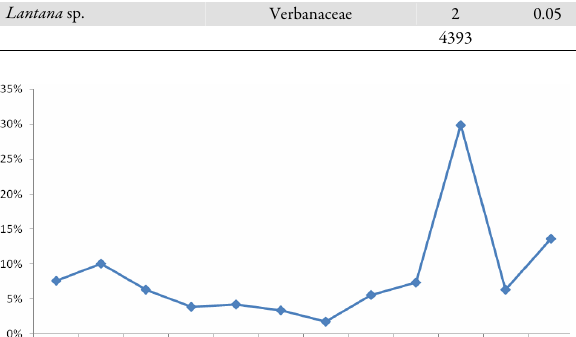
Fig. 3. Percentage pollen abundance in Shomolu Local Government